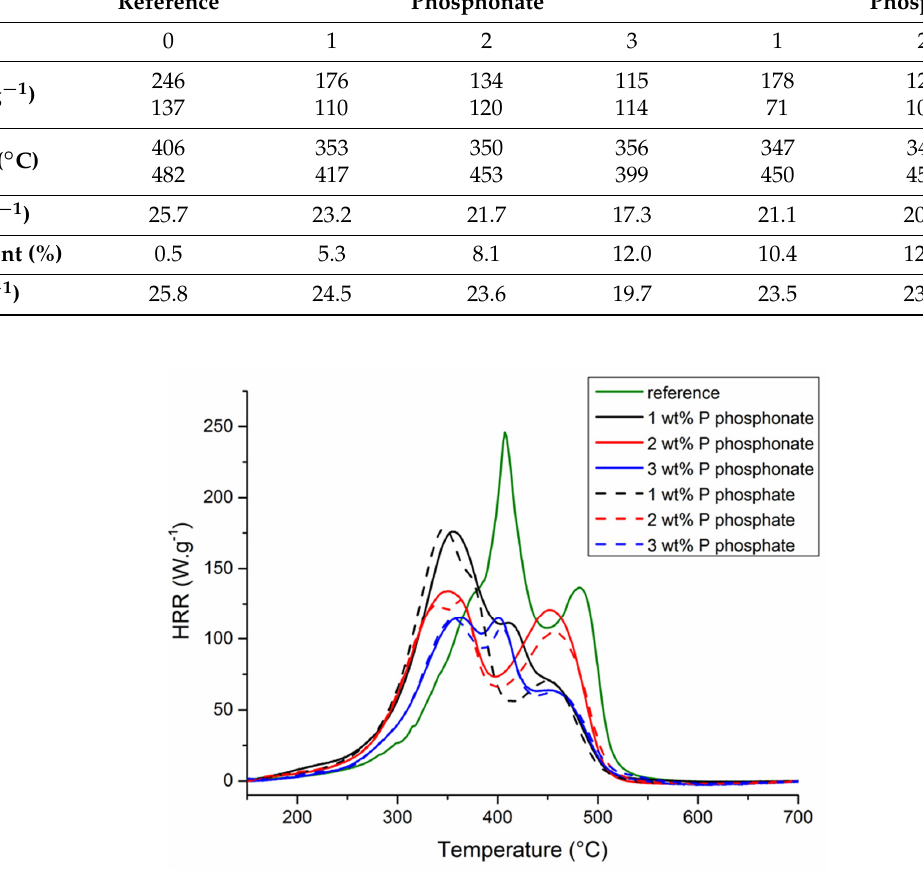
Figure 5. PCFC curves of reference alkyd resin and phosphorylated cardanol modified alkyd resins. Table 4. Results of PCFC analyses of PO x CR diluent alkyd resins.